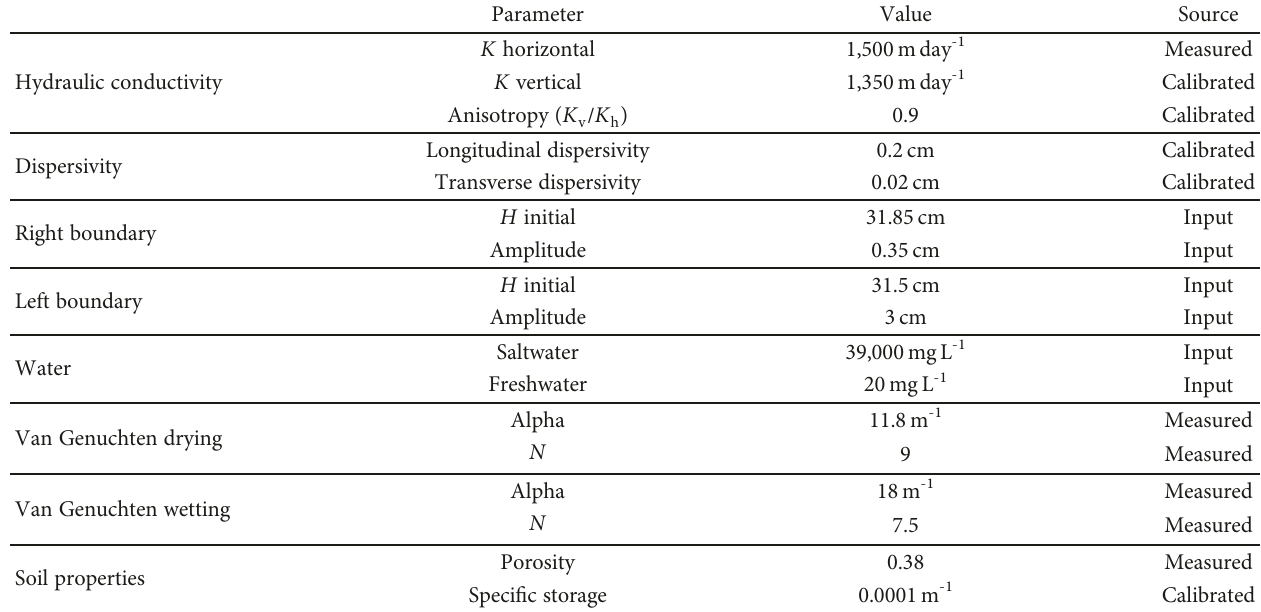
Table 1: Parameters used for the numerical simulations. Measured values were quanti fi ed in a speci fi c test. Calibrated values were assessed during the numerical